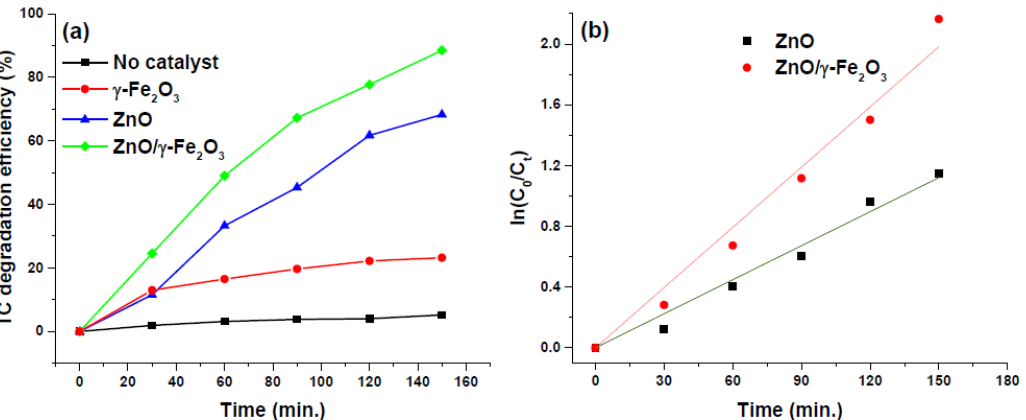
Figure 5. ( a ) Degradation e ffi ciency of TC (%) vs irradiation time (min) curves obtained in the absence of catalyst, and in presence of ZnO flower-like and ZnO / γ -Fe 2 O 3 composite catalysts; ( b ) First-order fitting plot to study the kinetic of TC photodegradation reaction catalyzed by ZnO flower-like and ZnO / γ -Fe 2 O 3 composite materials.